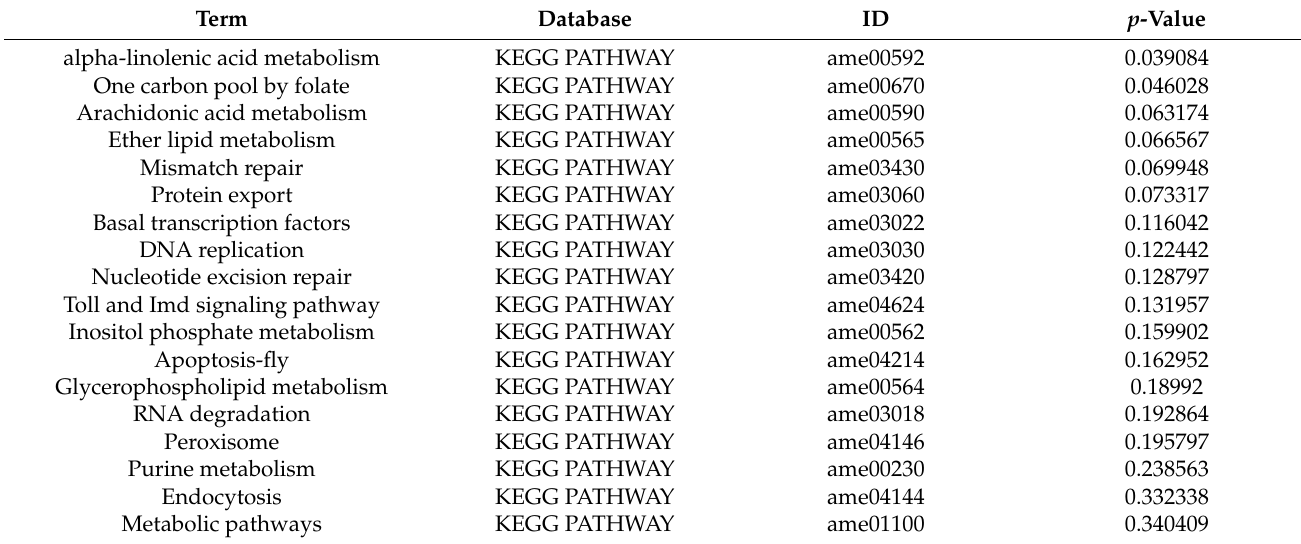
Table 2. KEGG enrichment analysis of genes under selection of Method 1.